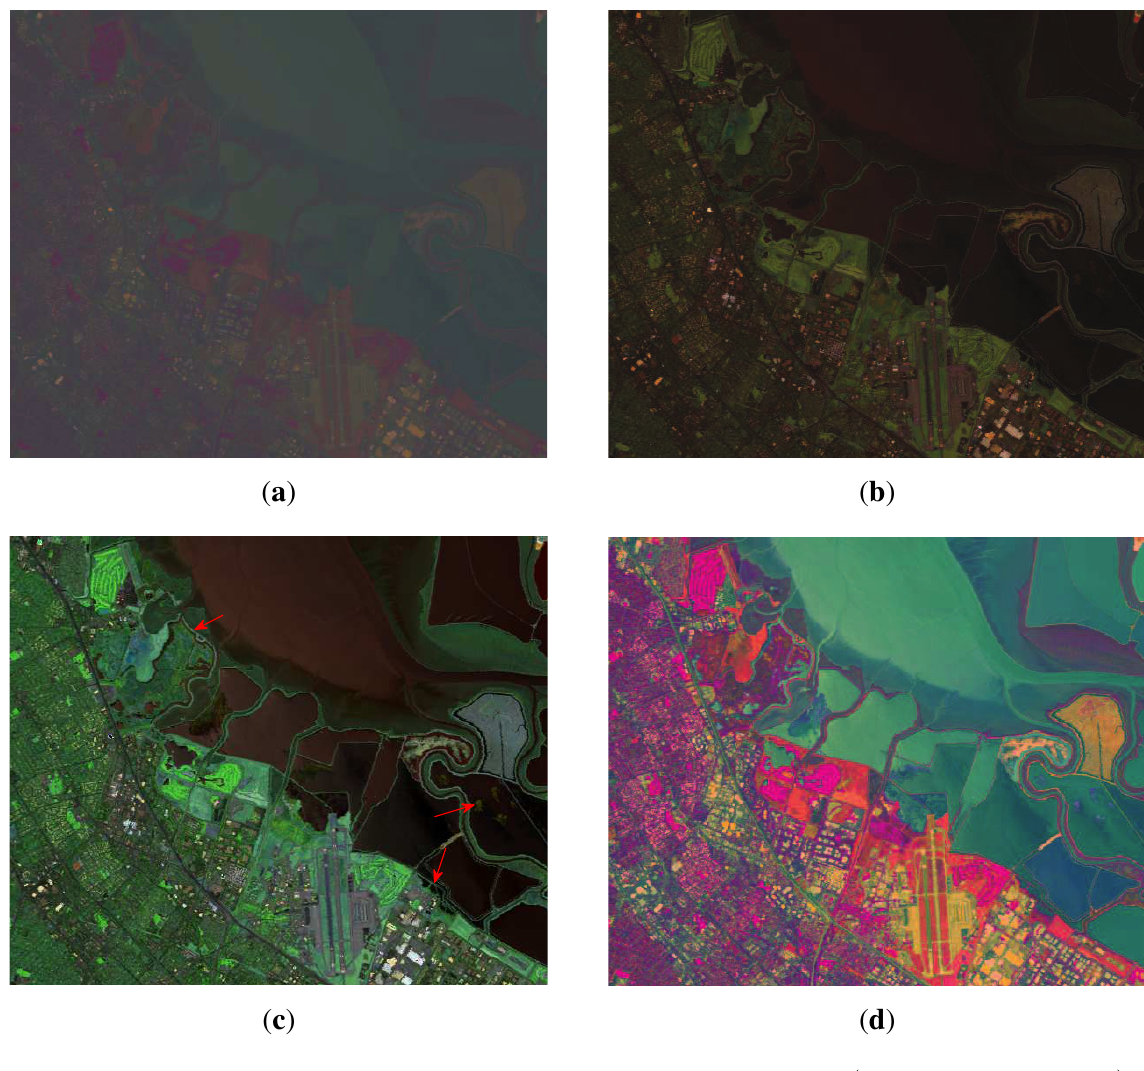
_ igm with range of (821 : 1332 , 51 : 642) 03